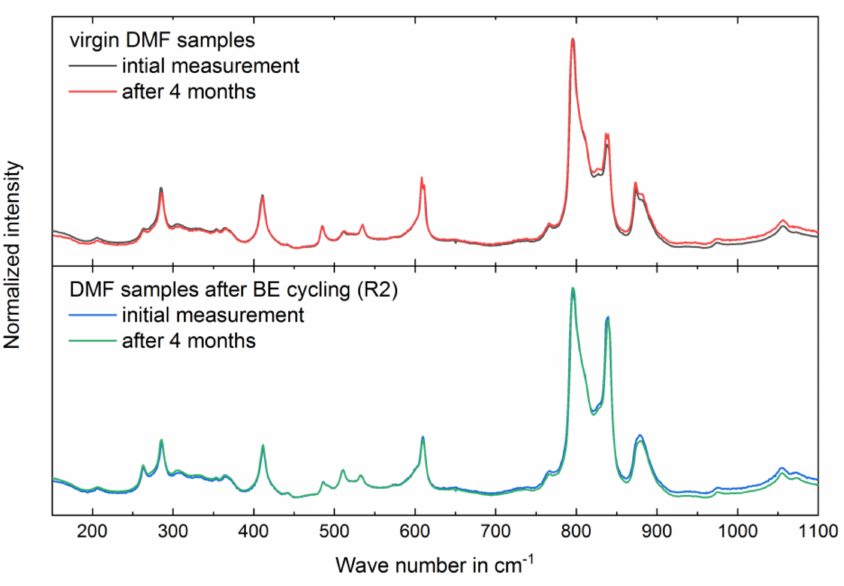
Figure 7. Raman spectra of samples from DMF solution. Virgin samples (without BE cycling) ( top ): initial (black) and repeated measurement (red). BE cycled samples ( bottom ): initial measurement (blue) after BE cycling (R2) and repeated measurement (green). Repeated measurements were conducted 4 months after the initial measurements (see Materials and Methods